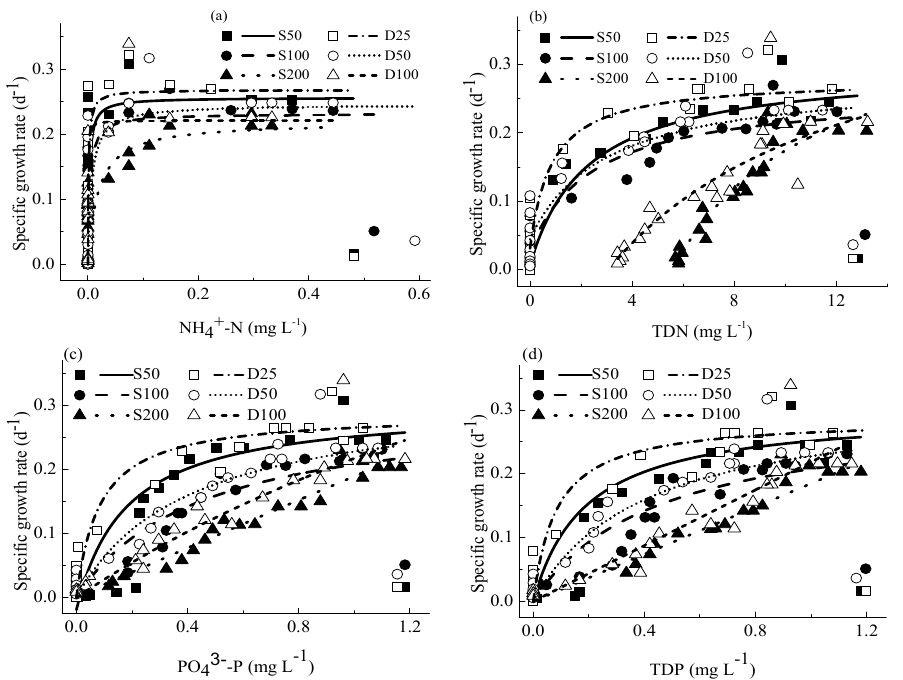
Figure 3. Fitting curves of Monod equation to the datasets of computed specific growth rates by modified logistic equation and concentrations of nutrients: ( a ), NH 4+ -N concentrations; ( b ), TDN concentrations; ( c ), PO 43− -P concentrations; ( d ), TDP concentrations.